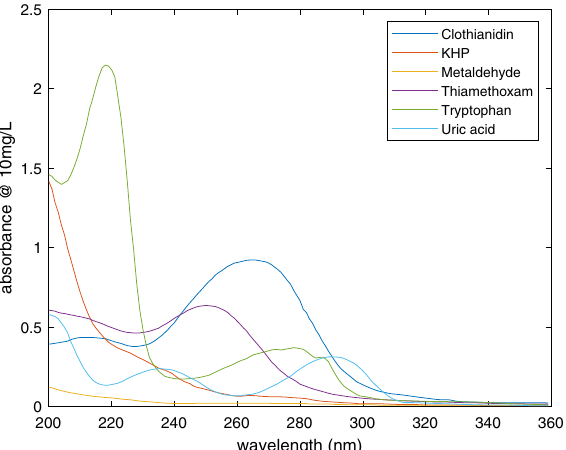
Figure 1. Absorption spectra for metaldehyde, clothianidin, tryptophan, thiamethoxam, potassium hydrogen pthalate (KHP) and uric acid, at 10 mg/L for 10 mm optical